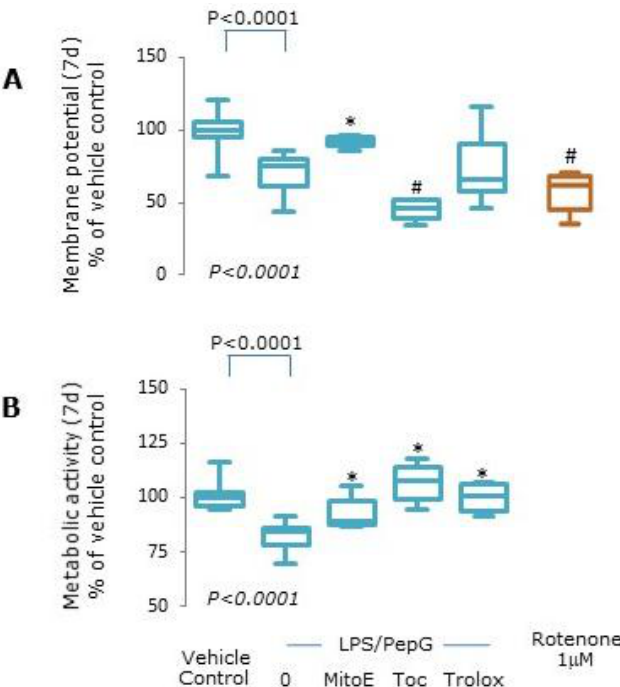
Figure 2. Oxidative stress. Endothelial cells were treated with vehicle control, lipopolysaccharide plus peptidoglycan (LPS / PepG) alone, or LPS / PepG plus 5 µ M MitoVitE (MitoE), tocopherol (Toc) or Trolox for 7 d, or 1 µ M rotenone. ( A ) Mitochondrial membrane potential, ( B ) metabolic activity. Box and whisker plots show median, interquartile and full range ( n = 6). p -value in italics refers to Kruskal–Wallis across LPS / PepG treated groups. # = significantly lower and * = significantly higher, than LPS / PepG alone ( p < 0.05).